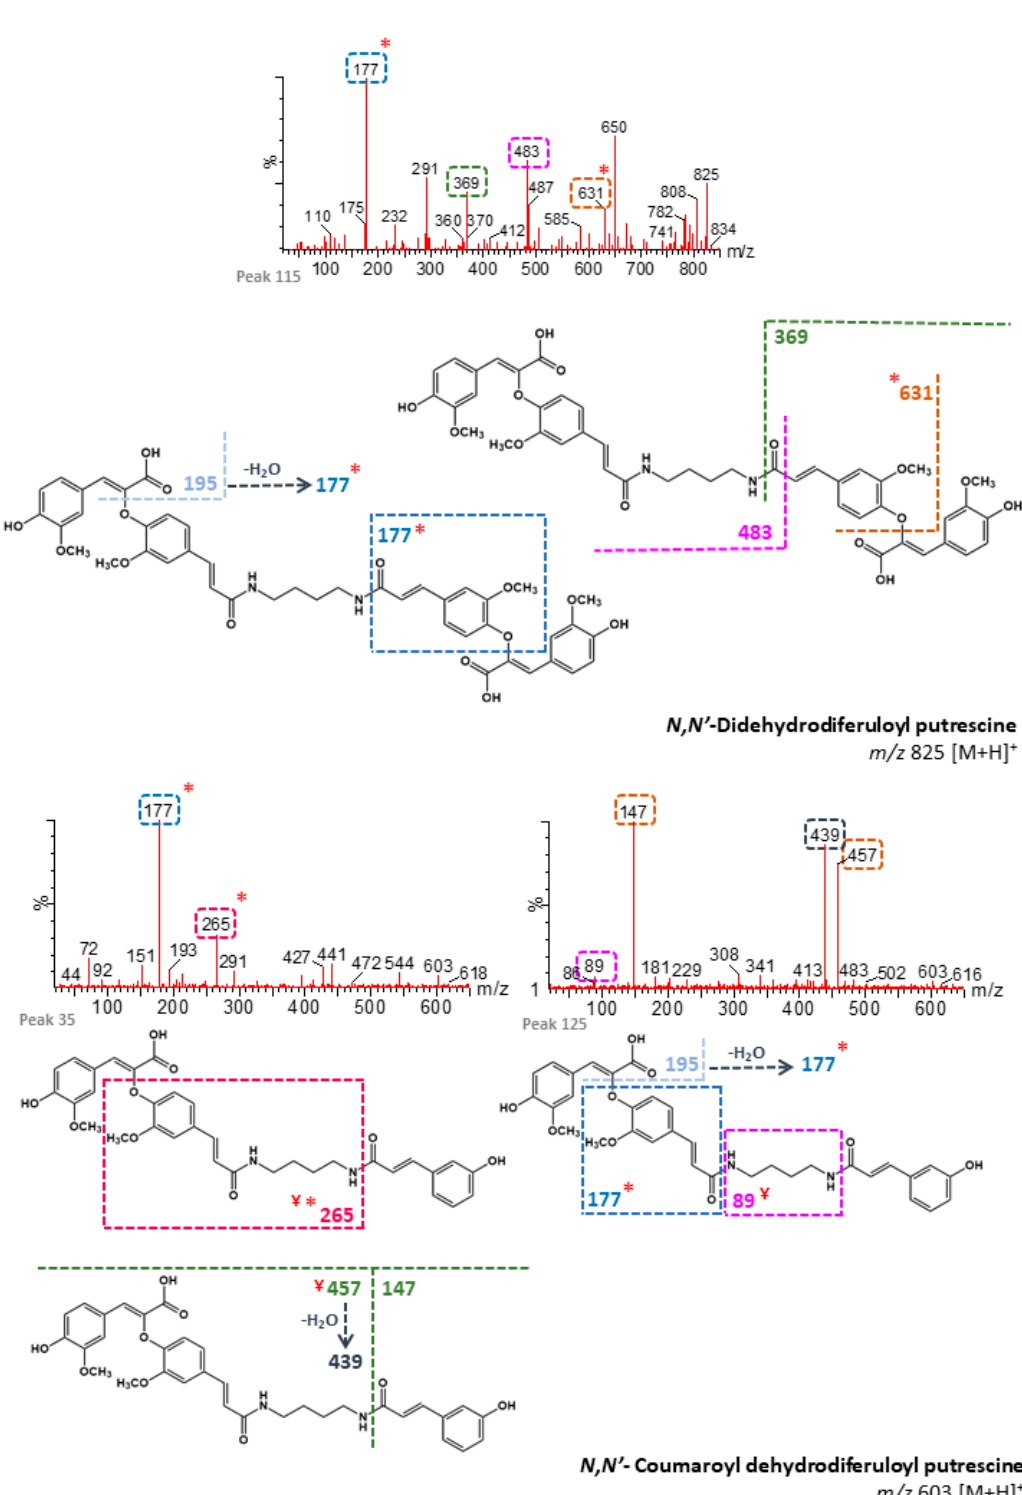
Figure 4. Fragmentation patterns proposed for dehydrodiferuloyl (8-O-4 ′ -DFA) putrescines. * : Characteristic product ions of C-O linkages between feruloyl moieties. Ұ : Product ions formed after amine protonation .